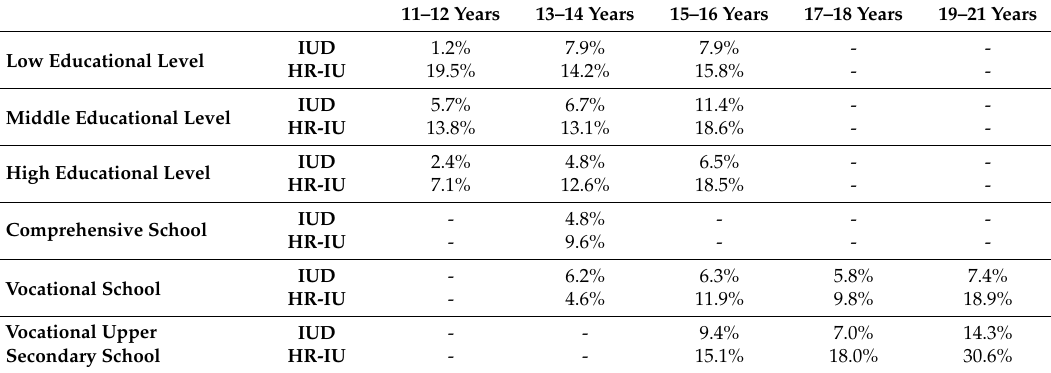
Table 4. Associations of school type (separated by age group) and prevalence of